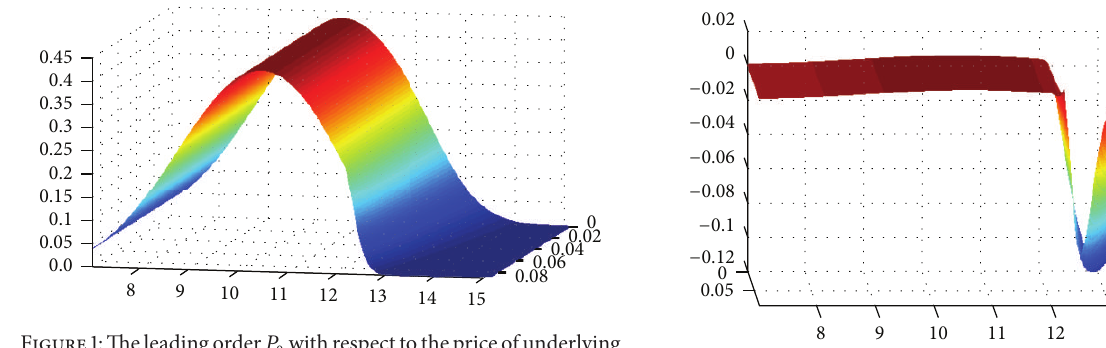
1 with respect to the price of underlying asset 𝑋 𝑡 and the barrier time 𝜏 𝑡